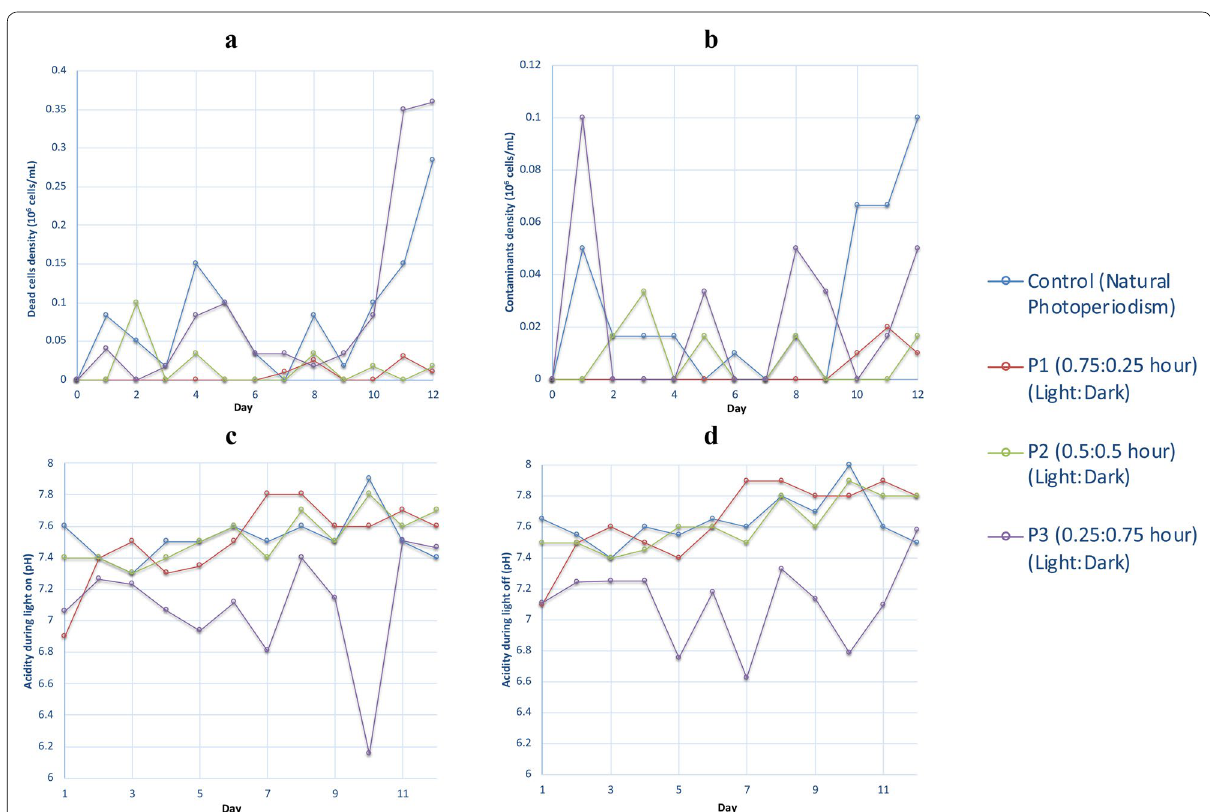
Fig. 6 Curve of (a) dead cells of Nannochloropsis sp., (B) contaminants, (c) pH graph when the light is on and (d) pH graph when the light is off in the four low-frequency flashing light